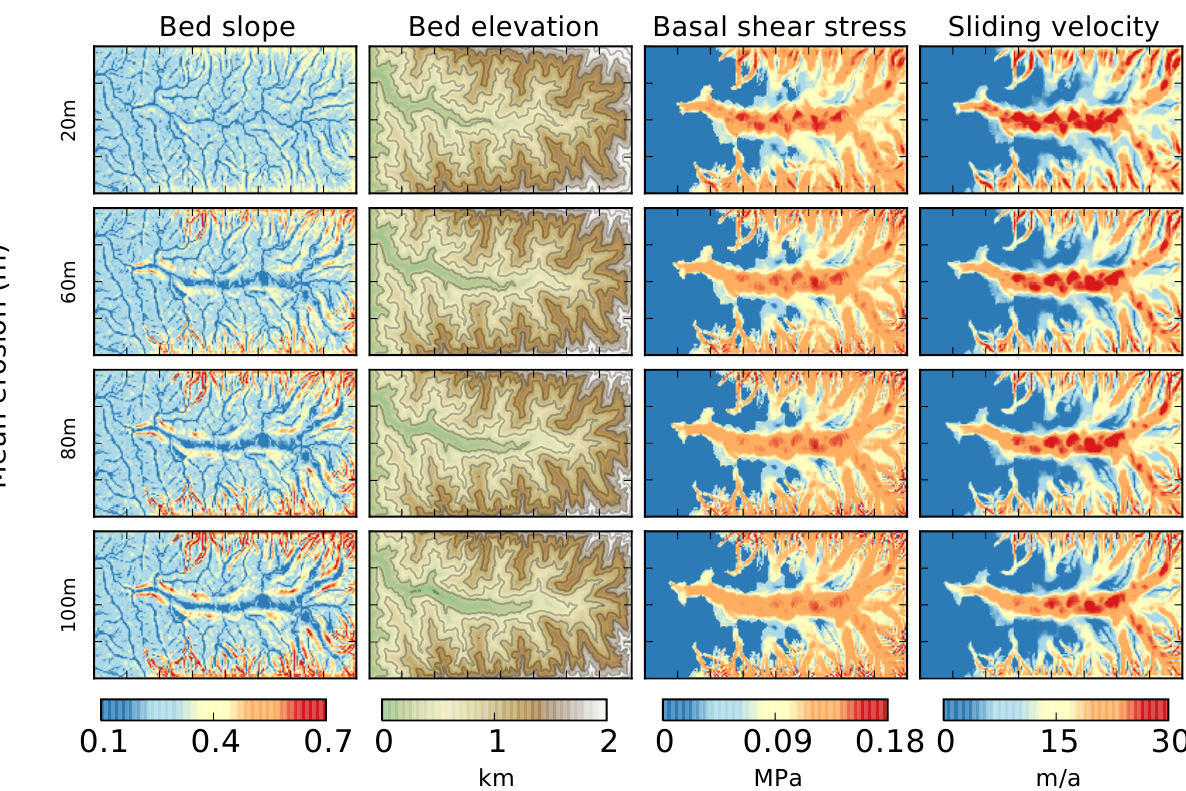
Figure 7. The results from experiment 3 with glacial erosion and using the Weertman sliding relation (Eq. 6) and m = 2 in Eq. (9). Each column shows bed slope, bed elevation, basal shear stress, and basal sliding speed at different stages of